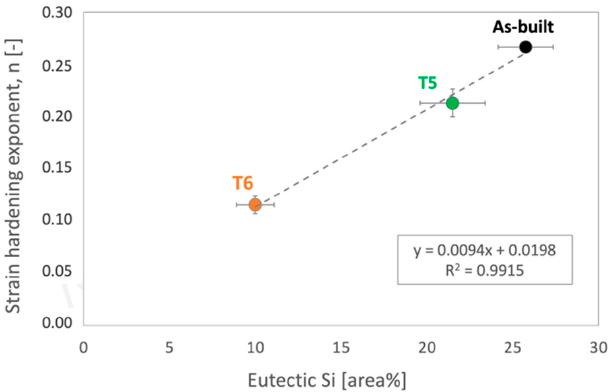
Figure 11. Correlation between strain hardening exponents n measured from true stress-true strain experimental curves and area% of the Si-rich region evaluated on FEG-SEM micrographs for the as-built, T5, and T6R AlSi7Mg PBF-LB tensile samples.